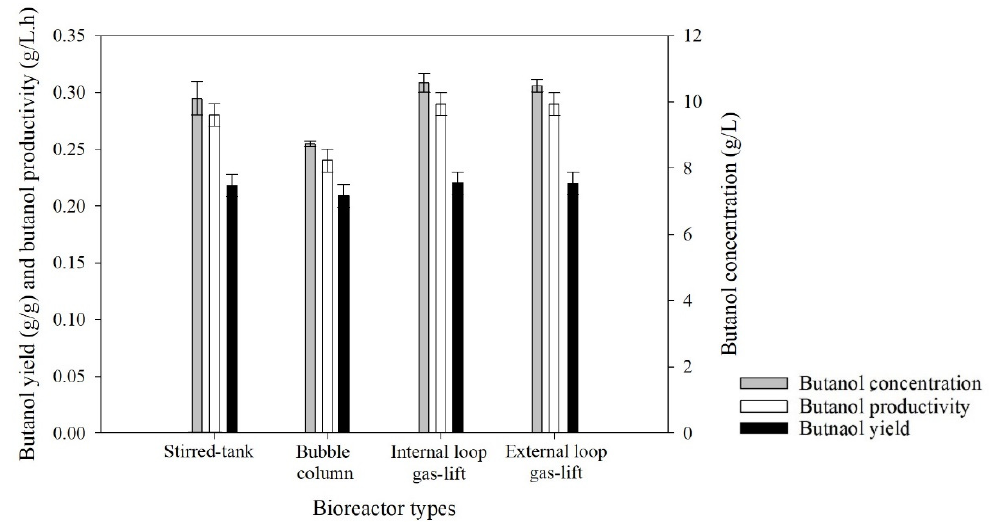
Figure 6. Comparison of butanol fermentation efficiency from sugarcane molasses by C. beijerinckii TISTR 1461 in various bioreactors. Table 4. Comparison of batch butanol fermentation efficiency from various